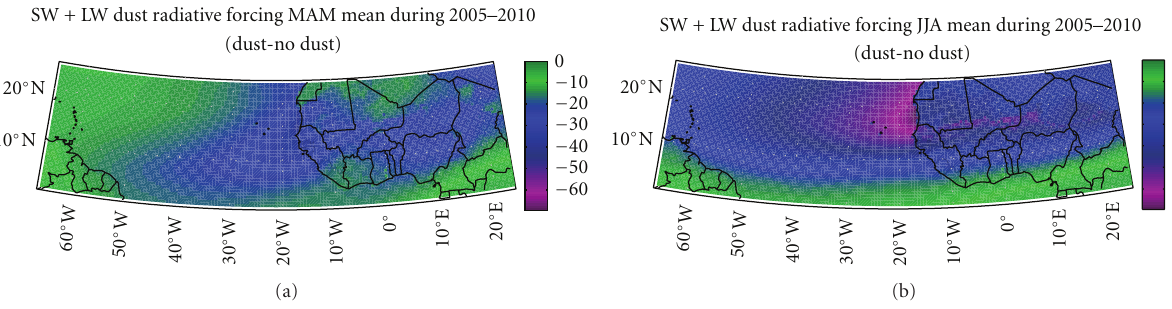
with elevated concentrations on Figures 8(b) and 9(b).